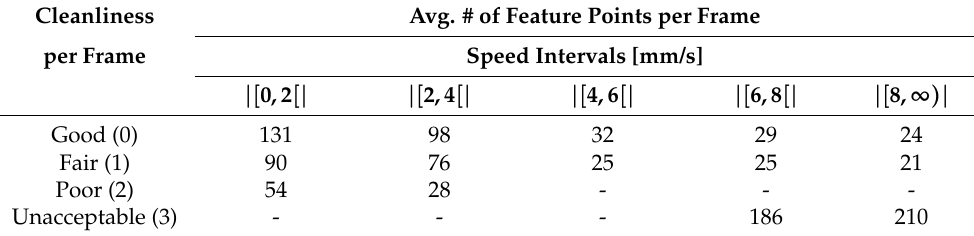
Table 1. Average number of feature points per frame conditioned on the cleanliness and estimated